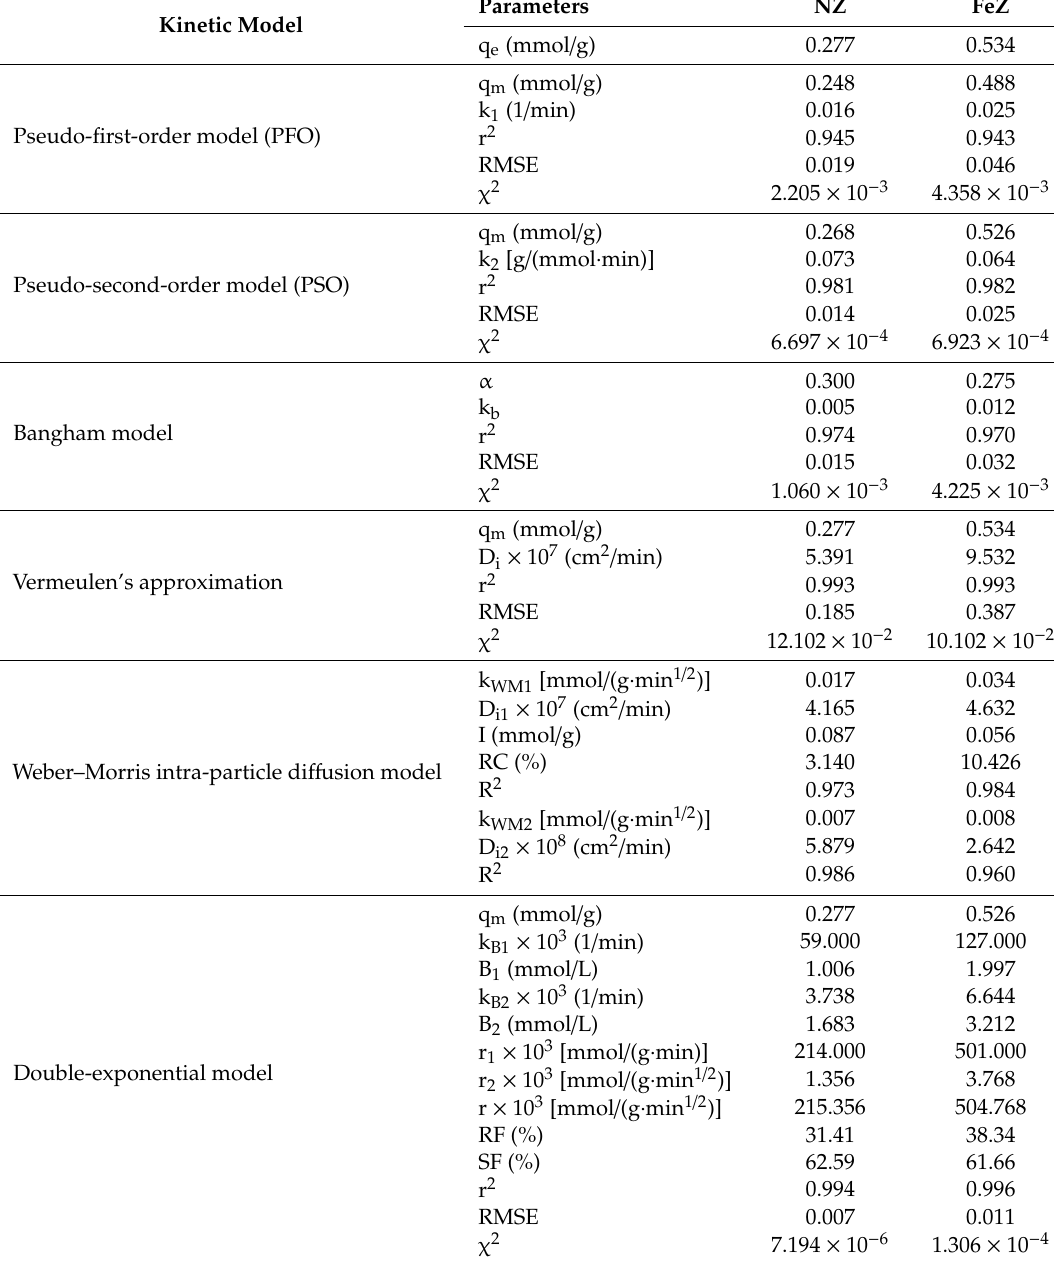
Table 1. Kinetic models constantss and error analysis for Hg(II) sorption onto NZ and